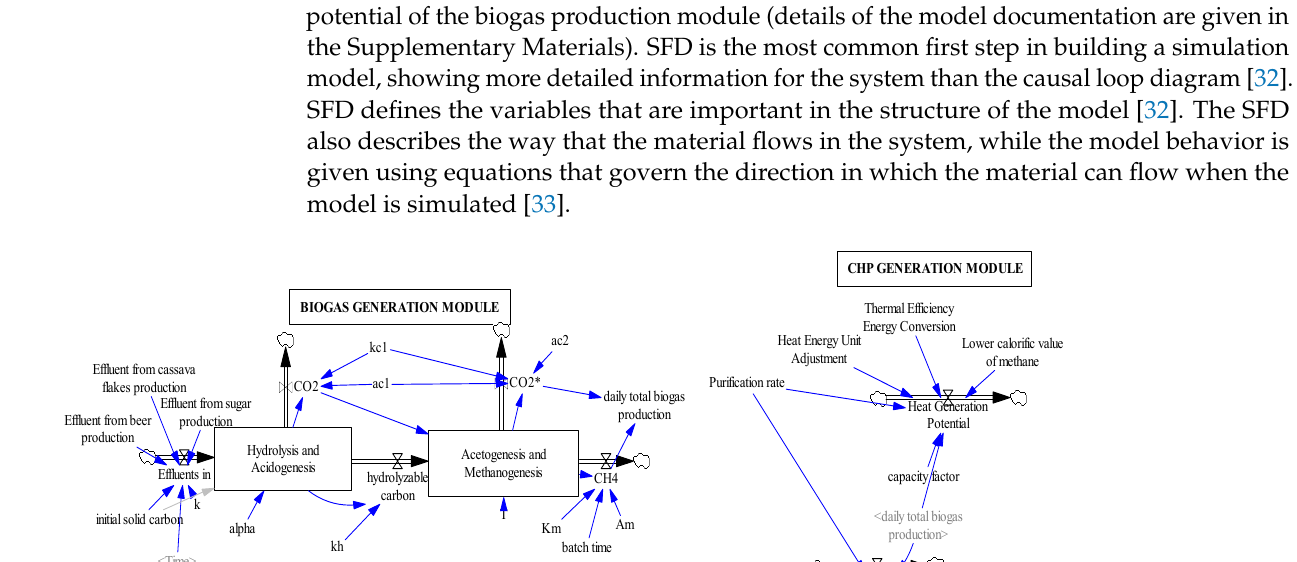
6 Figure 3. Causal diagram for effluents, biogas production, and energy recovery for CHP use. The specific materials of interest are cassava, used in making cassava flakes or garri ,